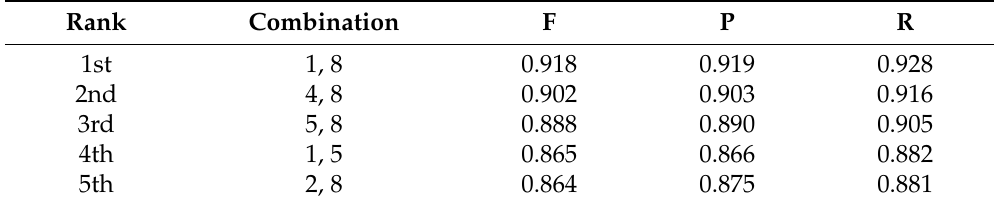
Table 3. Result of combination of two sensors with high accuracy in Evaluation 2. (R: Recall, P: Precision, F: F-value).